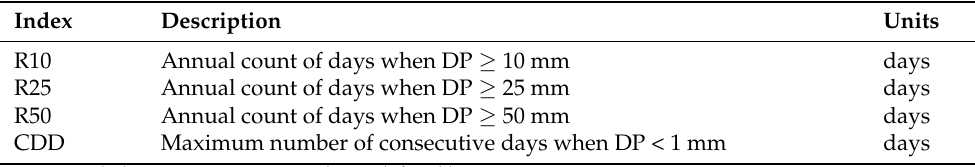
Table 2. Cont. Index Description Units R10 Annual count of days when DP ≥ 10 mm days R25 Annual count of days when DP ≥ 25 mm days R50 Annual count of days when DP ≥ 50 mm days CDD Maximum number of consecutive days when DP < 1 mm days DP means daily precipitation; a wet day is defined by DP ≥ 1